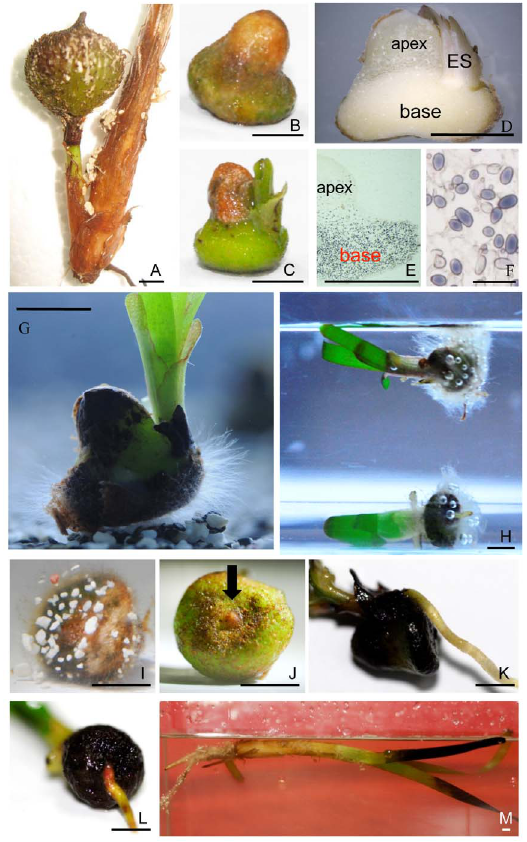
Figure 1. Fruit, seeds, and seedlings of T. hemprichii . A fruit attached to the base of a shoot (A). A typical seed with seed coat resembling a bell in shape (B). Seed germination at early stage (C). A longitudinal section of a seed illustrating texture difference between the apex and the base; ES, embryonic shoots (D). Uneven distribution of starch granules, stained by iodine in a longitudinal section, between the apex and the base (E). Magnification of the stained starch granules (F). A germinating seed with root hair-like filamentous cells emerging from